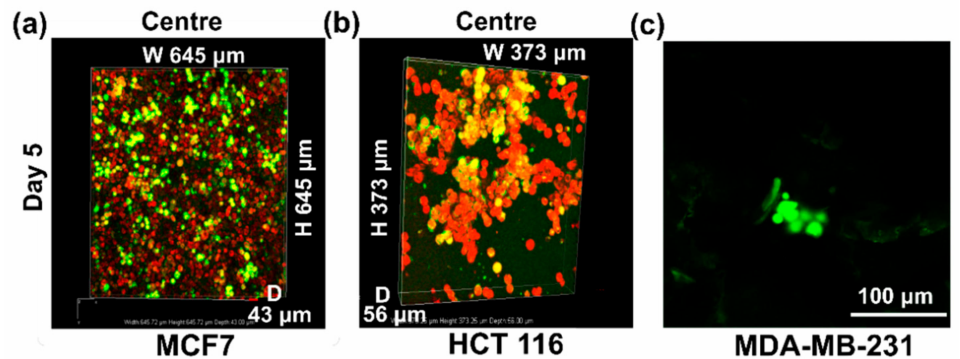
Figure 8. Comparison of cell growth patterns of ( a ) MCF7, ( b ) HCT-116 stained with TMRM (Red) and ( c ) MDA-MB-231 cells stained with Calcein Green (Green), both for live